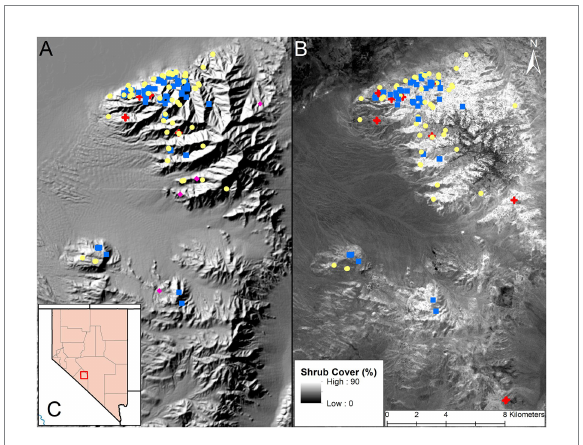
FIGURE 1 Map of the Lone Mountain and Weepah Hills study area outside of Tonopah, Nevada (2016–2018). Image (A) shows the location of fecal nitrogen samples used in our diet analyses, overlaid on a hill shade layer of the mountain range. Yellow circles represent pre-parturition samples, blue squares represent post parturition samples, red crosses represent post juvenile mortality samples, and pink diamonds represent not pregnant samples. Image (B) shows the location of diet composition samples used in our diet analyses, overlaid on a shrub cover layer (www.rangeland. app) of the mountain range. Shrub cover ranged from 0 to 90 percent throughout the region, lighter colors represent areas with high shrub cover and dark colors represent areas with low shrub cover. Yellow circles represent pre-parturition samples, blue squares represent post parturition samples, and red crosses represent post juvenile mortality samples. Image (C) shows the location of the Lone Mountain study site within a county outline map of